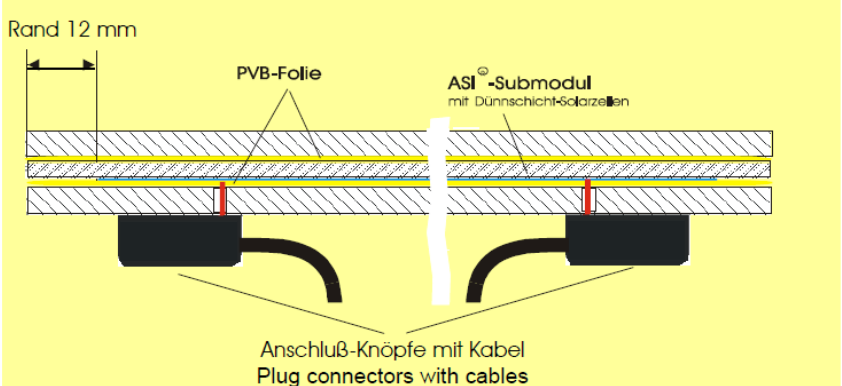
Figure 1: ASI-Submodul Arnold